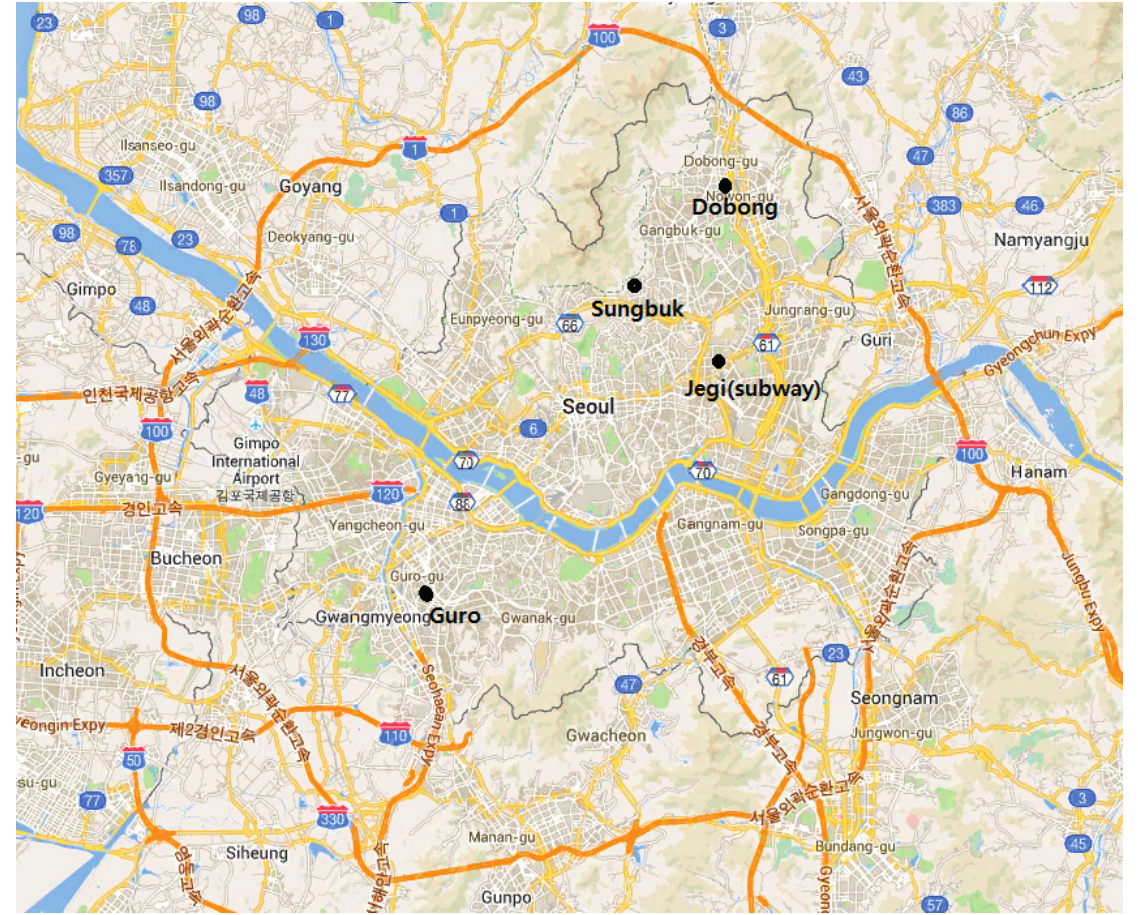
Figure 1. Passive sampling locations in Seoul,